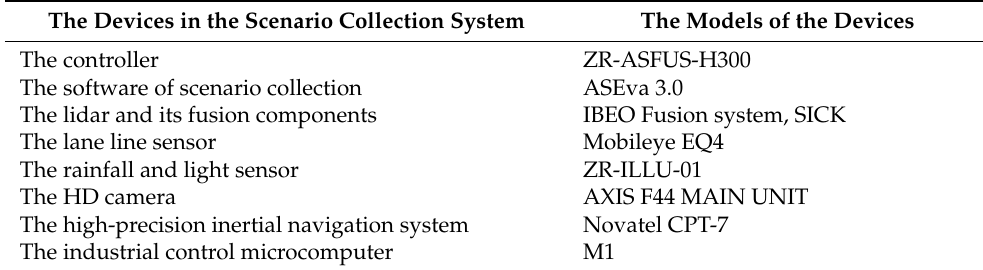
Figure 9. The distribution of the collection areas of the NDD. Table 5. The device specifications in the scenario collection Table 5. The device specifications in the scenario collection system.